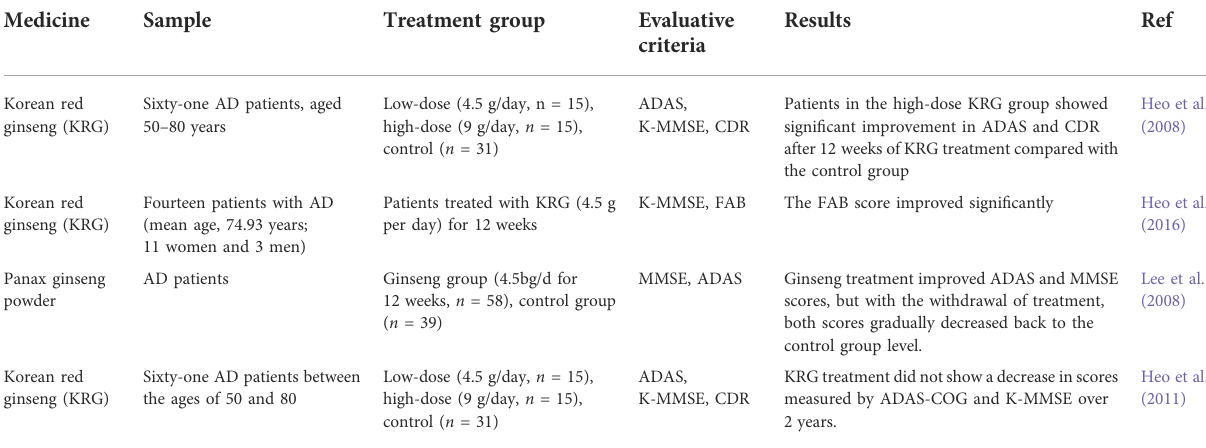
TABLE 2 Summary of clinical trials of ginseng intervention in